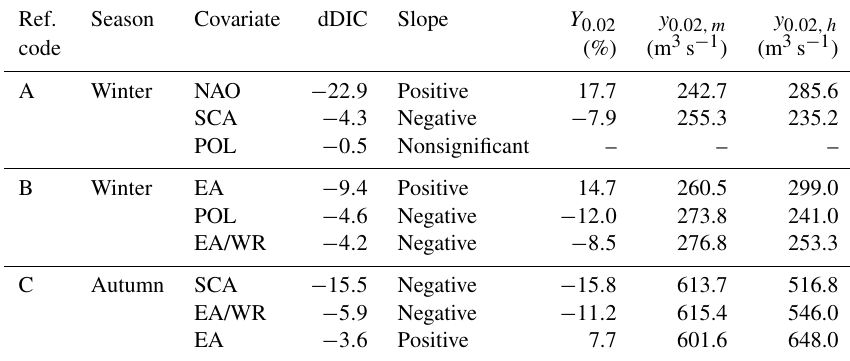
Table 6. Climate-informed results as shown in Fig. 7. Ref. code is the number of the subplot of Fig. 7. Mean seasonal covariates for the same season as streamflow extremes are examined. dDIC is the difference from the DIC value of the classical distribution. Y 0 . 02 ( % ) is the percent relative difference of streamflow with exceedance probability 0.02 for the 95th quantile of the covariate ( y 0 . 02 ,h ) and of streamflow with exceedance probability 0.02 for the median ( y 0 . 02 ,m ). The sign of the slope is reported if it is significantly different than zero at the 10% significance